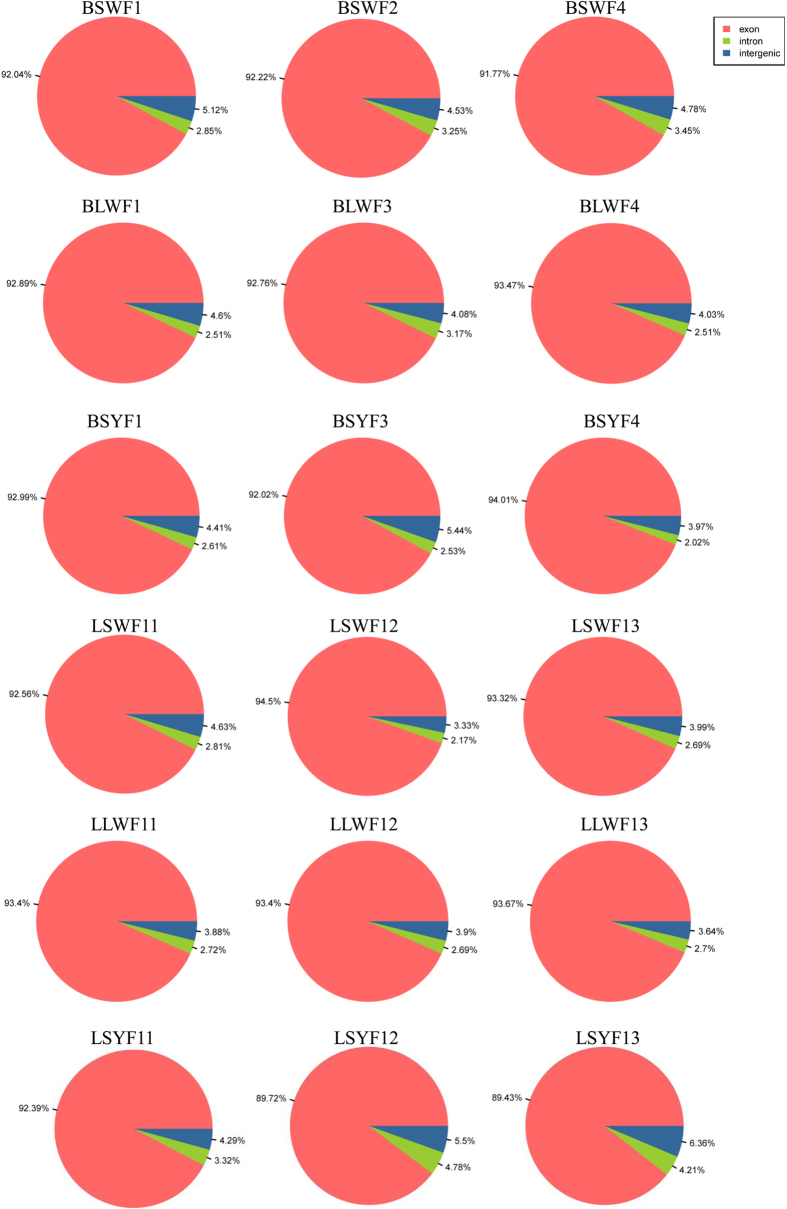
Distribution statistics of reads mapped to reference genes.